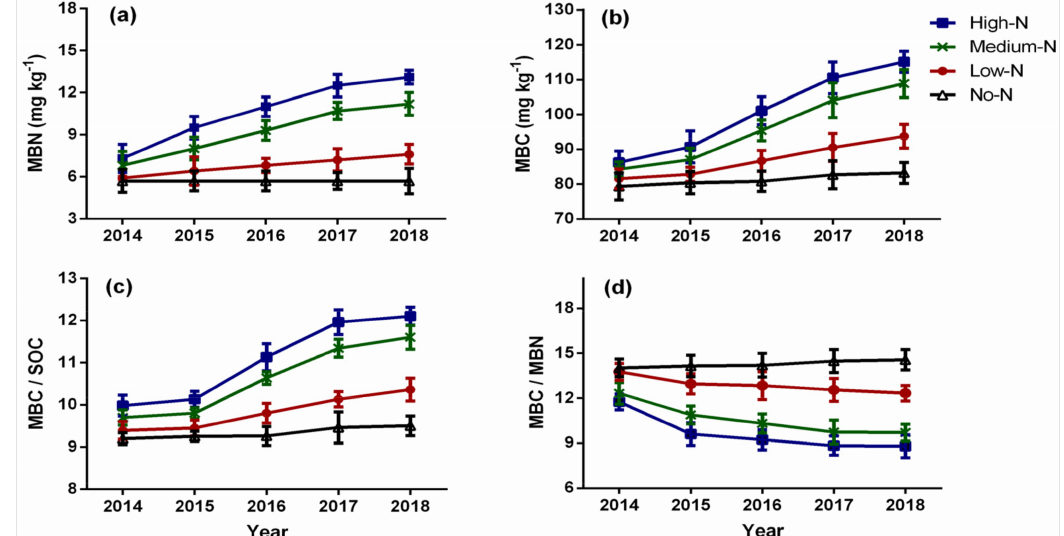
Figure 3. Effects of nitrogen enrichment on microbial biomass nitrogen ( a ), microbial biomass carbon ( b ), microbial biomass carbon and soil organic carbon ratio ( c ), microbial biomass carbon and microbial biomass nitrogen ratio ( d ). MBN = microbial biomass nitrogen; MBC = microbial biomass carbon; SOC = soil organic carbon. Bars represent ± standard error of means, with four replications.